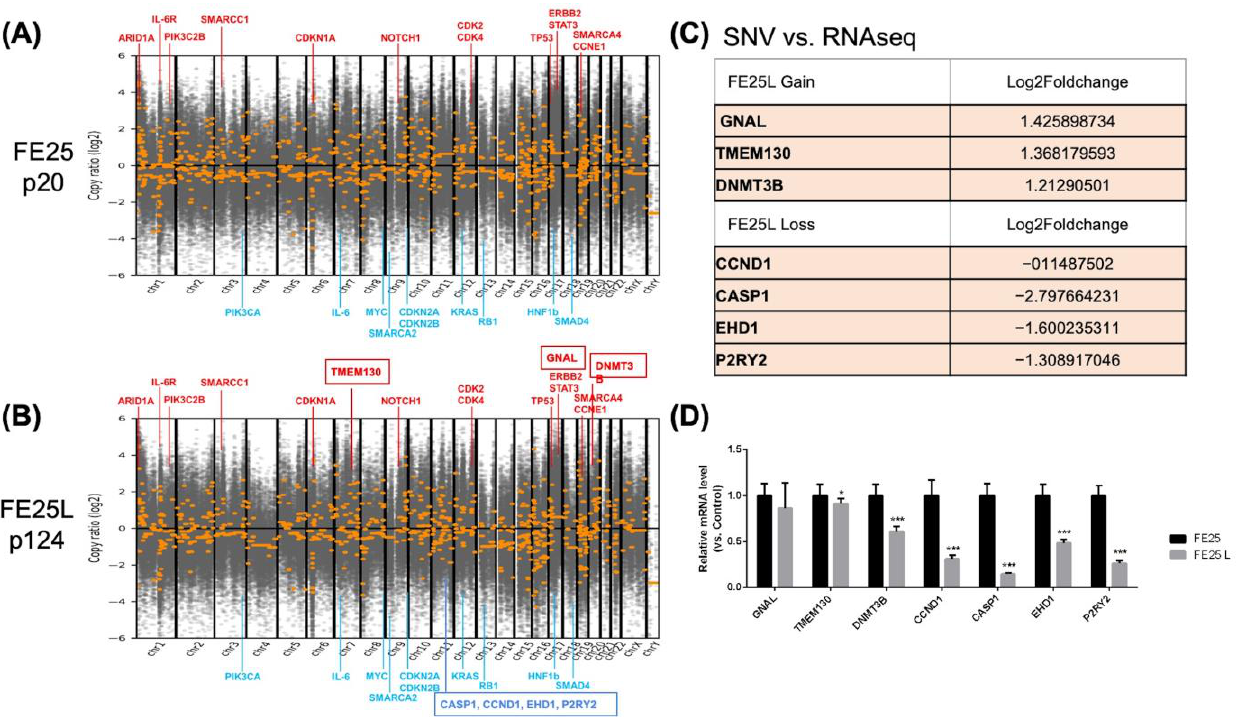
Figure 6. DNA copy number of FE25 (p20) and FE25L (p124) cells revealed by whole exome sequencing. ( A , B ) The position of the chromosome is listed in x -axis. y -axis showed the gain or loss of copy number in log 2 . Red color line with gene name indicates amplified loci and water blue color line with gene name indicates deleted loci of the two cell lines as compared to the normal genome. ( C ) Table shows genes with somatic varied copy number (SNV) upon FE25 to FE25L progression, which also showed a compatible mRNA alteration as revealed by RNA sequencing. ( D ) The genes listed in Table ( C ) were further confirmed by qRT-PCR. *** p < 0.001. * p < 0.05.